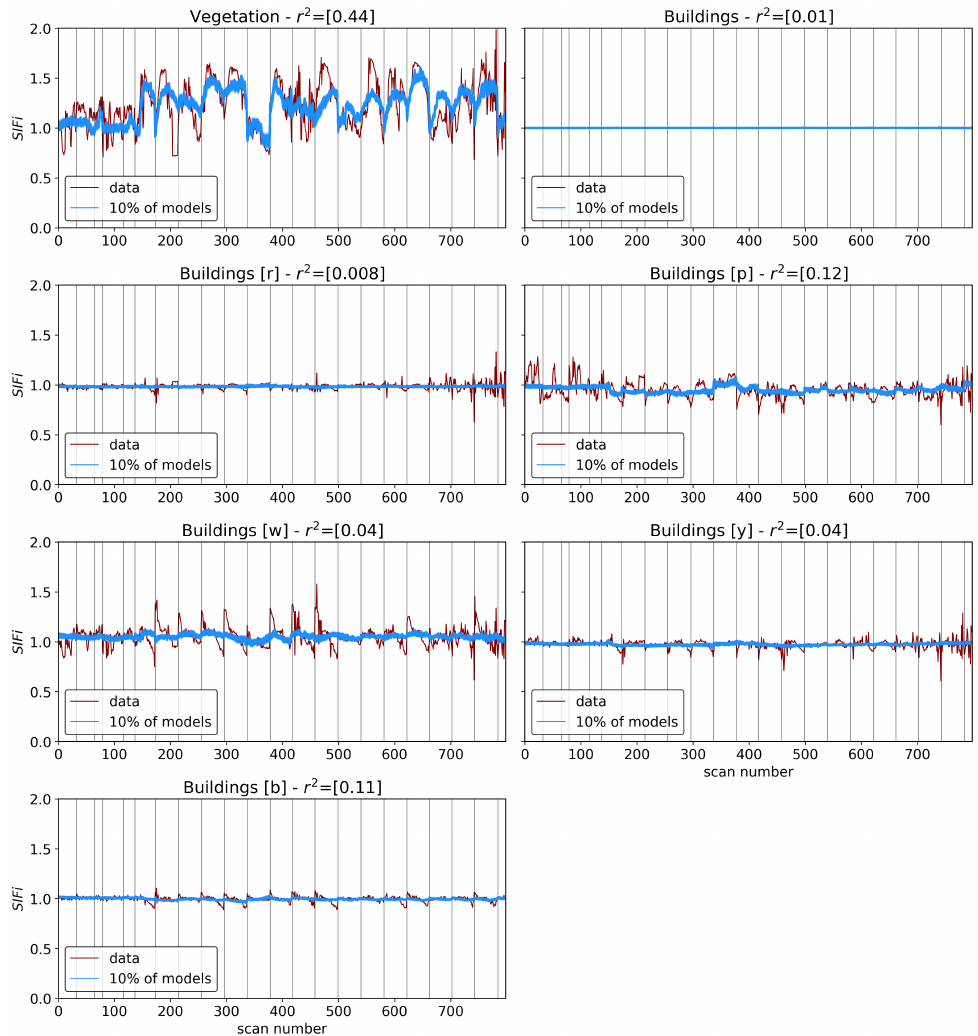
Figure A6. The SIFi of vegetation and all objects identified in Figure A5 together with 10% of models randomly selected from those identified as probable by MCMC, with the vertical lines indicating the change in days, and the r 2 of the line of best fit printed in the title of each